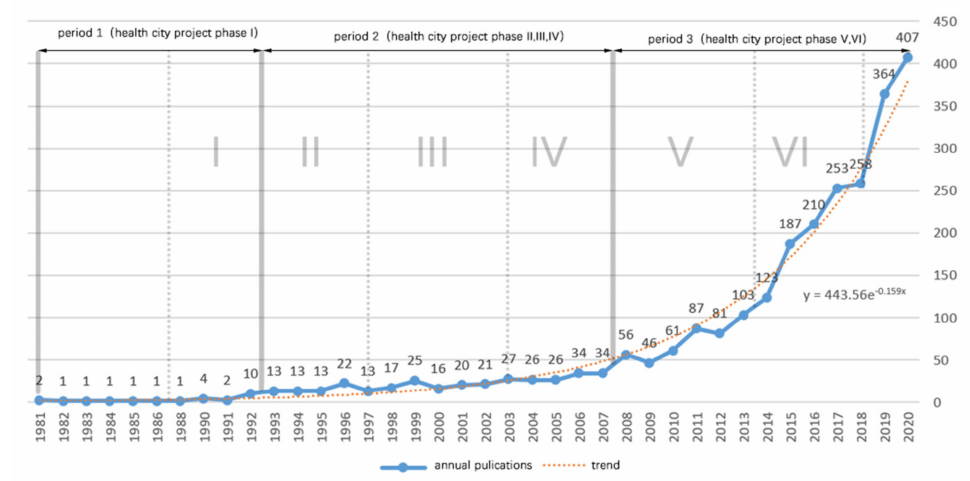
Figure 5. Number of published papers on healthy urban planning